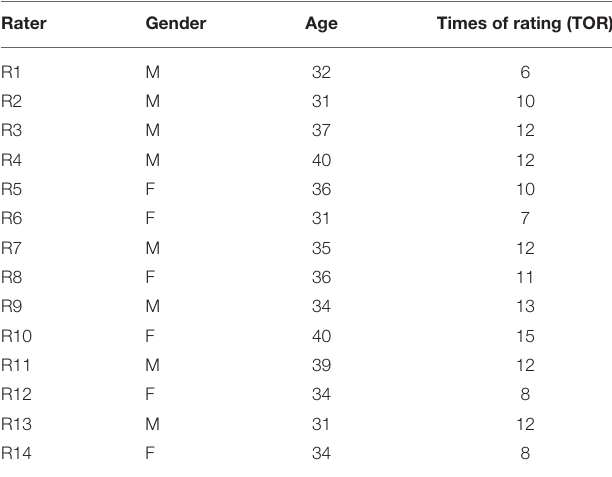
TABLE 1 | The profile of 14 raters who rated 10 essays with TAPs.